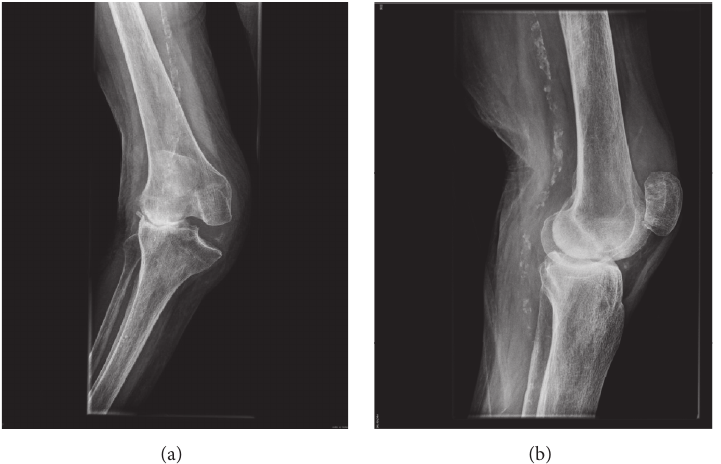
Figure 2: Preoperative standing X-rays of the knee: anteroposterior (a) and lateral (b) view. There is a valgus alignment of 47 ∘ (grade III valgus osteoarthritis). Significant wear and destruction of the lateral